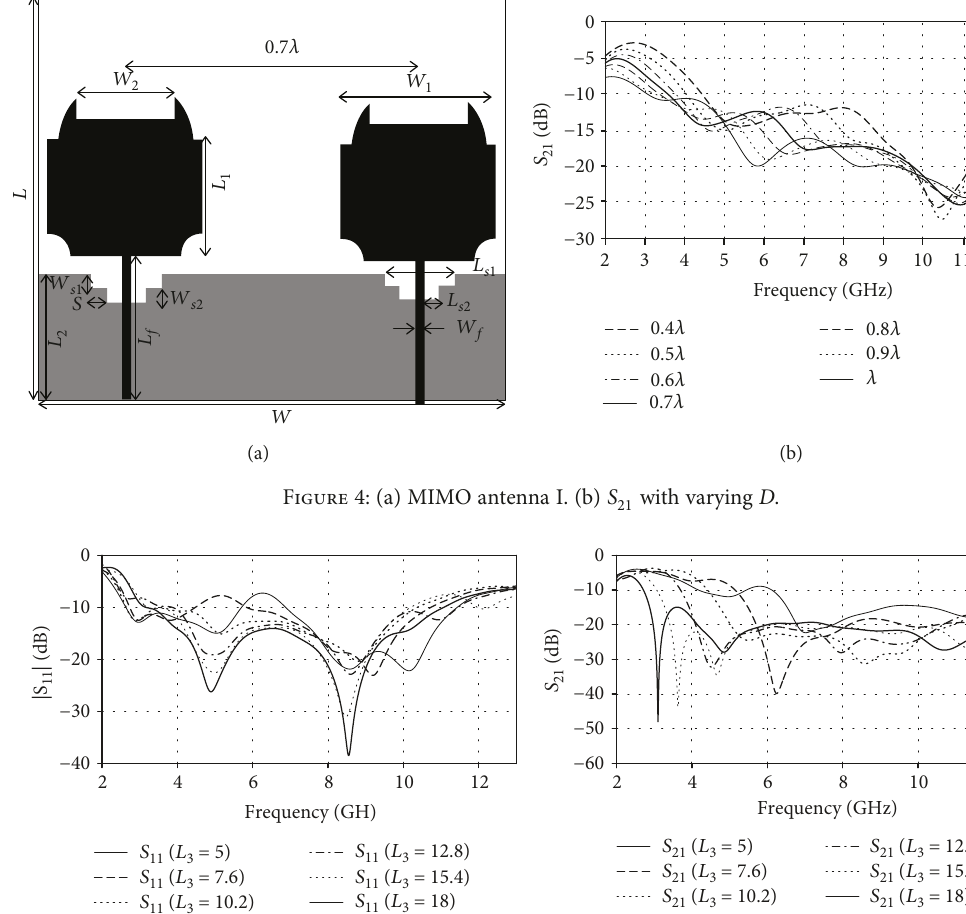
21 with varying D .